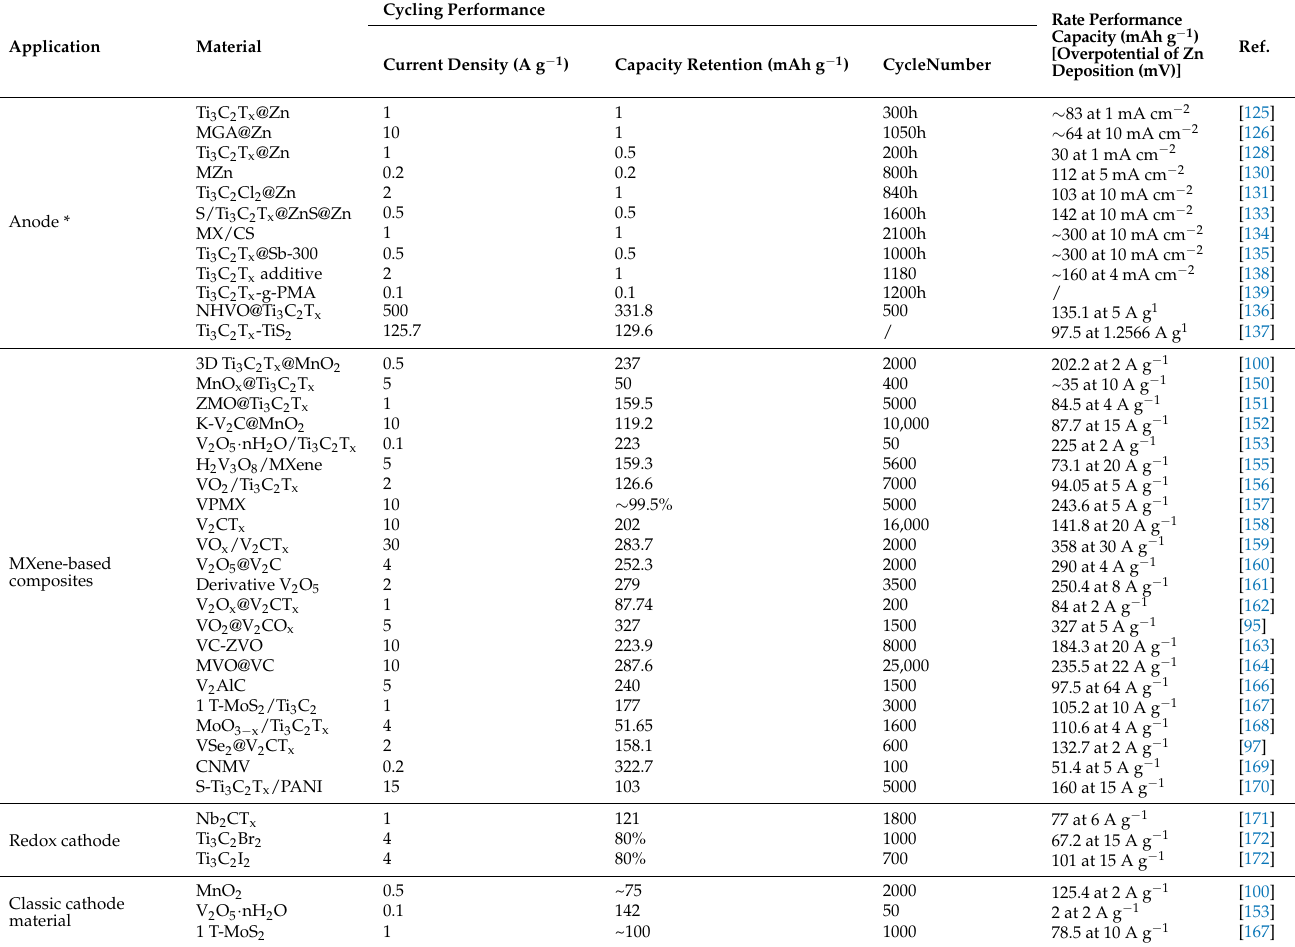
Table 4. Applications of MXene and MXene-based composites in